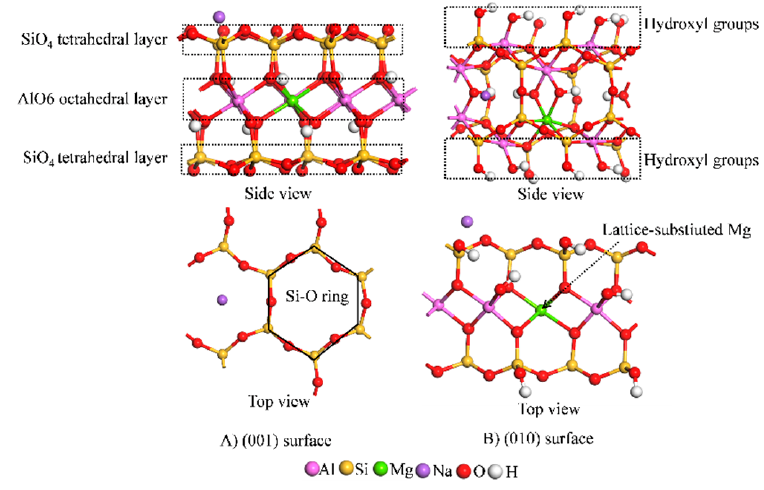
Figure 1. Montmorillonite surface models: (A) (001) surface and (B) (010) surface.